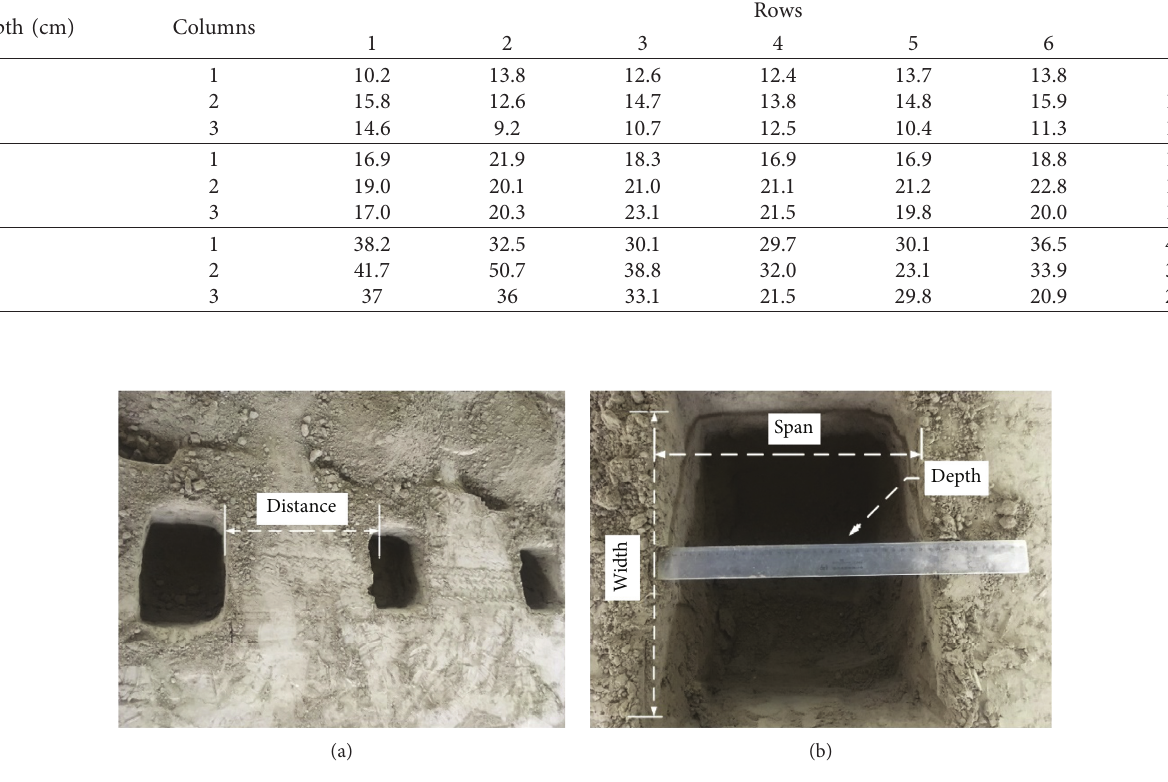
Figure 2: Sample of the rectangular